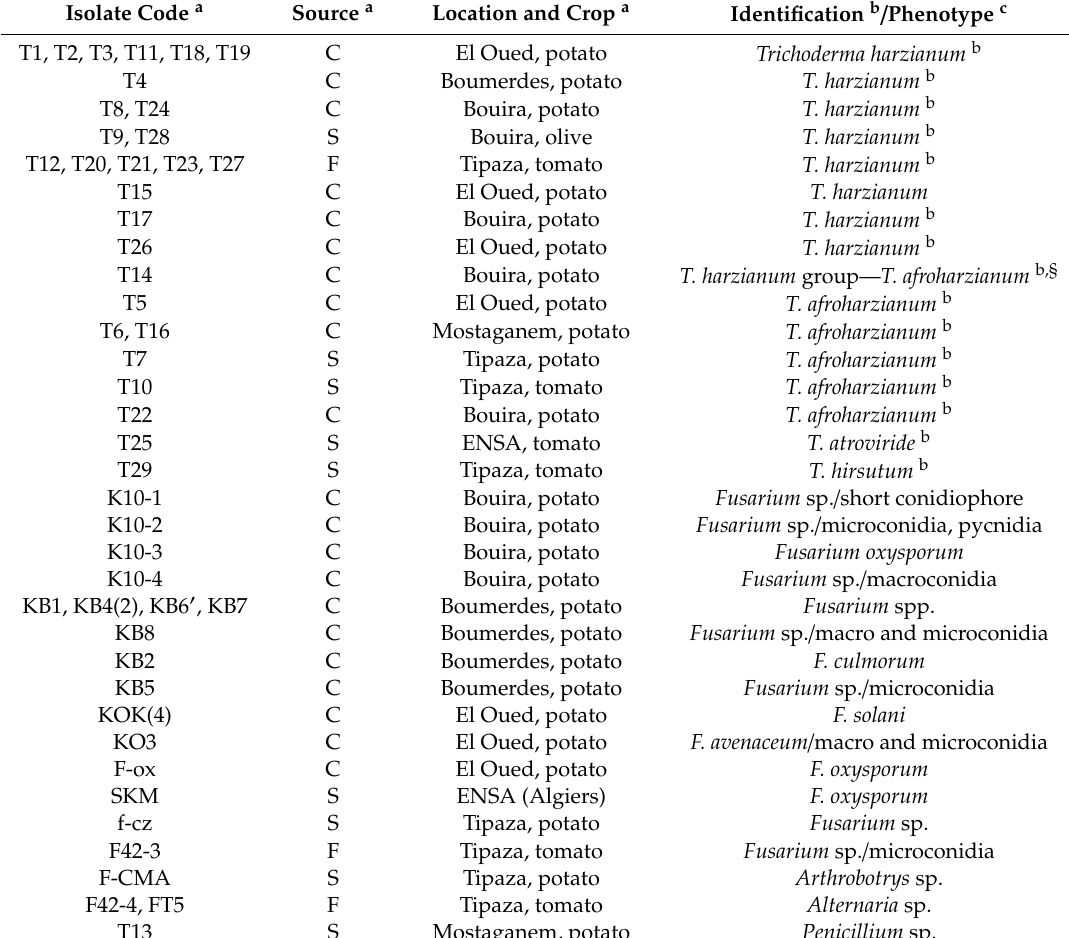
Table 1. List of the fungi isolated from the cysts of Globodera rostochiensis , the females of Meloidogyne spp. or rhizosphere soil, from food crops sampled in